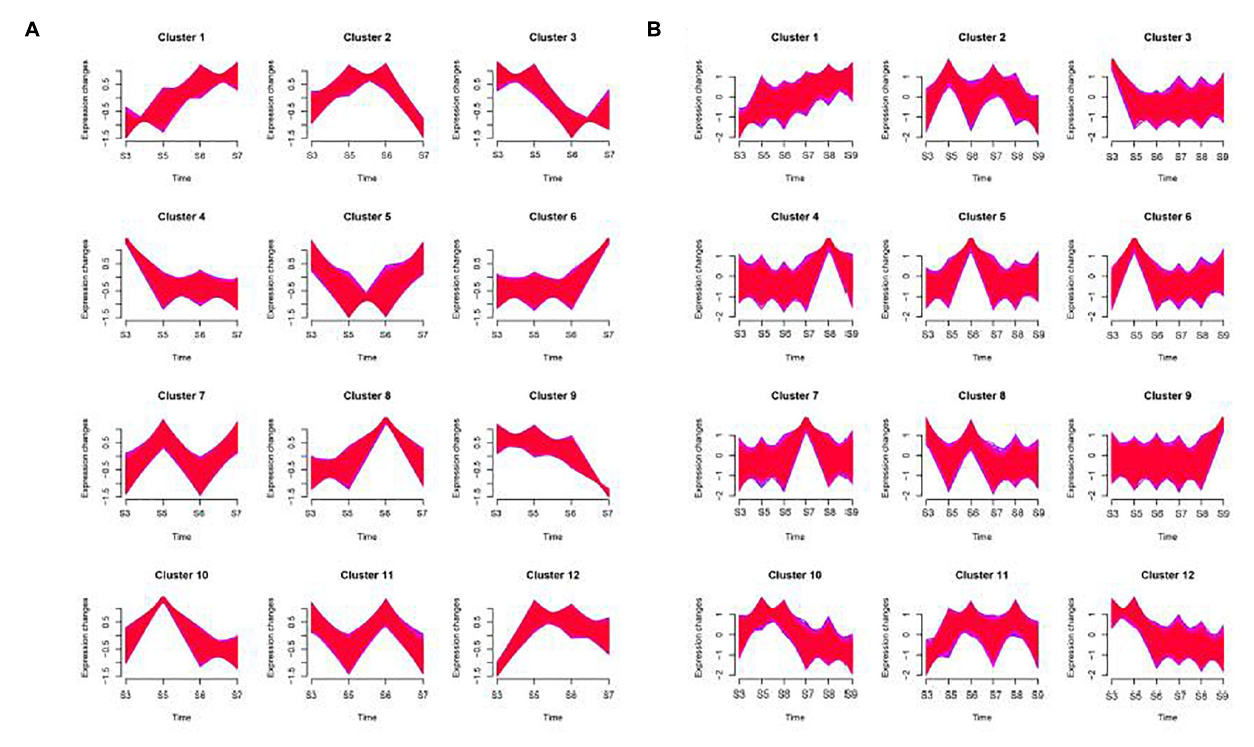
FIGURE 5 | Time series analysis of genes on ‘Ganlv 2’ (A) and ‘Ganlv 1’ (B) . According to the trend of gene expression, genes with consistent expression patterns will be clustered into the same cluster. The red area was composed of multiple lines of gene expression line chart. The edges of the red area were framed with blue